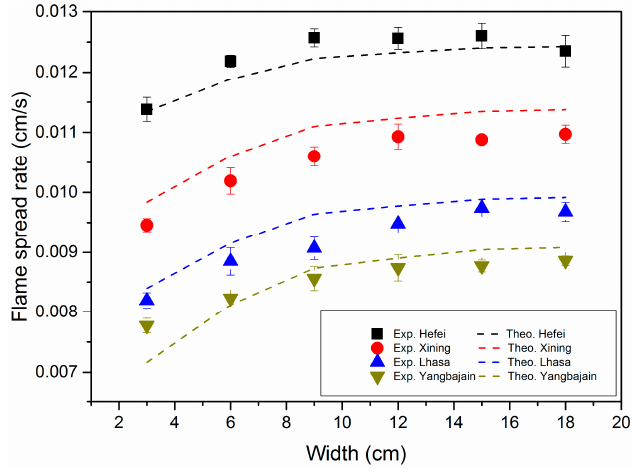
Figure 5. Comparisons between experimental and theoretical flame spread rates over a 5 mm slab for different widths under different pressure environments.